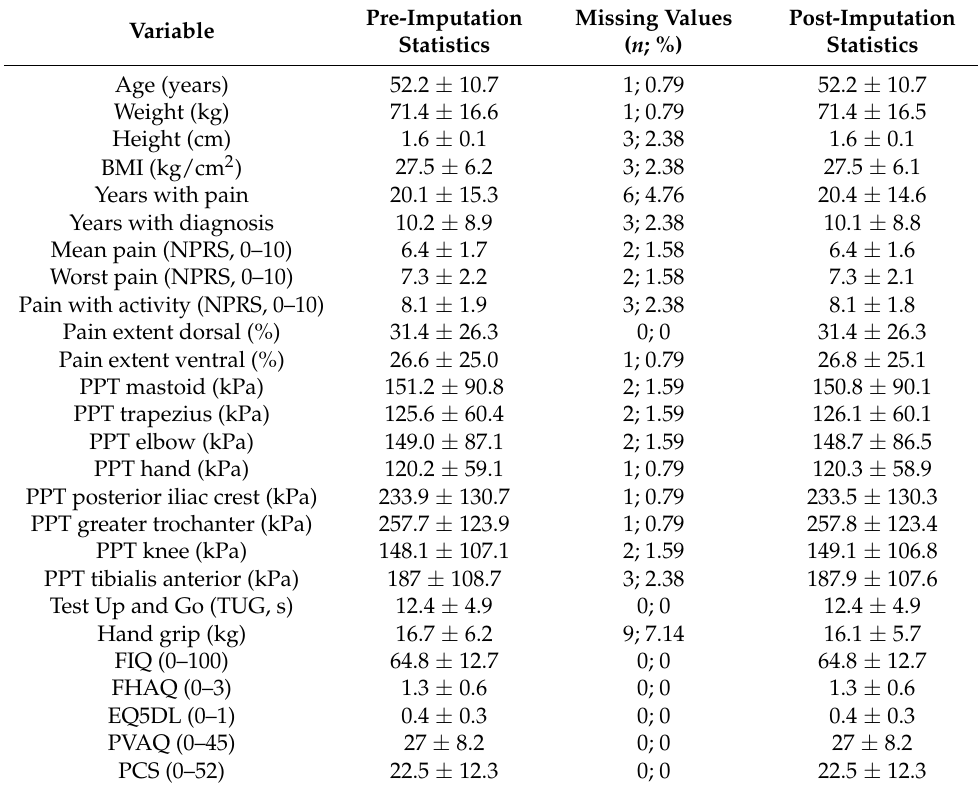
Table 1. Values (mean ± standard deviation) of demographic, clinical, sensory-related, psychological, and psychophysical variables of the total sample ( n =